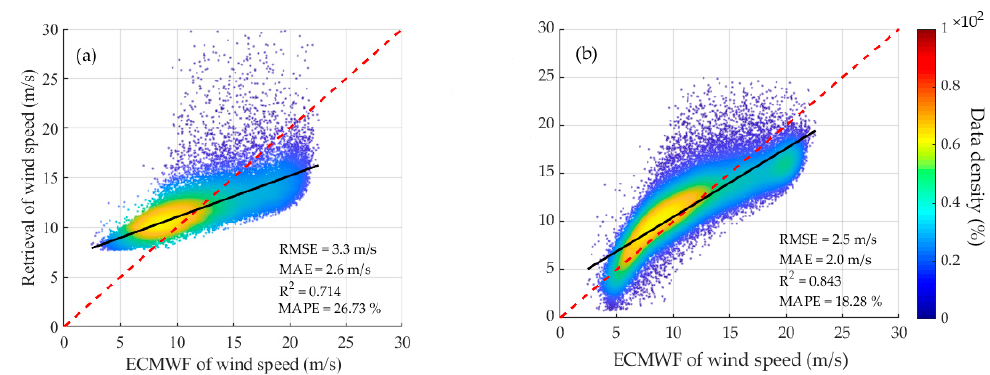
Figure 15. Scatter plots for estimated wind speed and ECMWF wind speed derived from LES with two models. ( a ) and ( b ) correspond to Model-1 and Model-2, respectively. Colors (from cold to warm) represent data density.